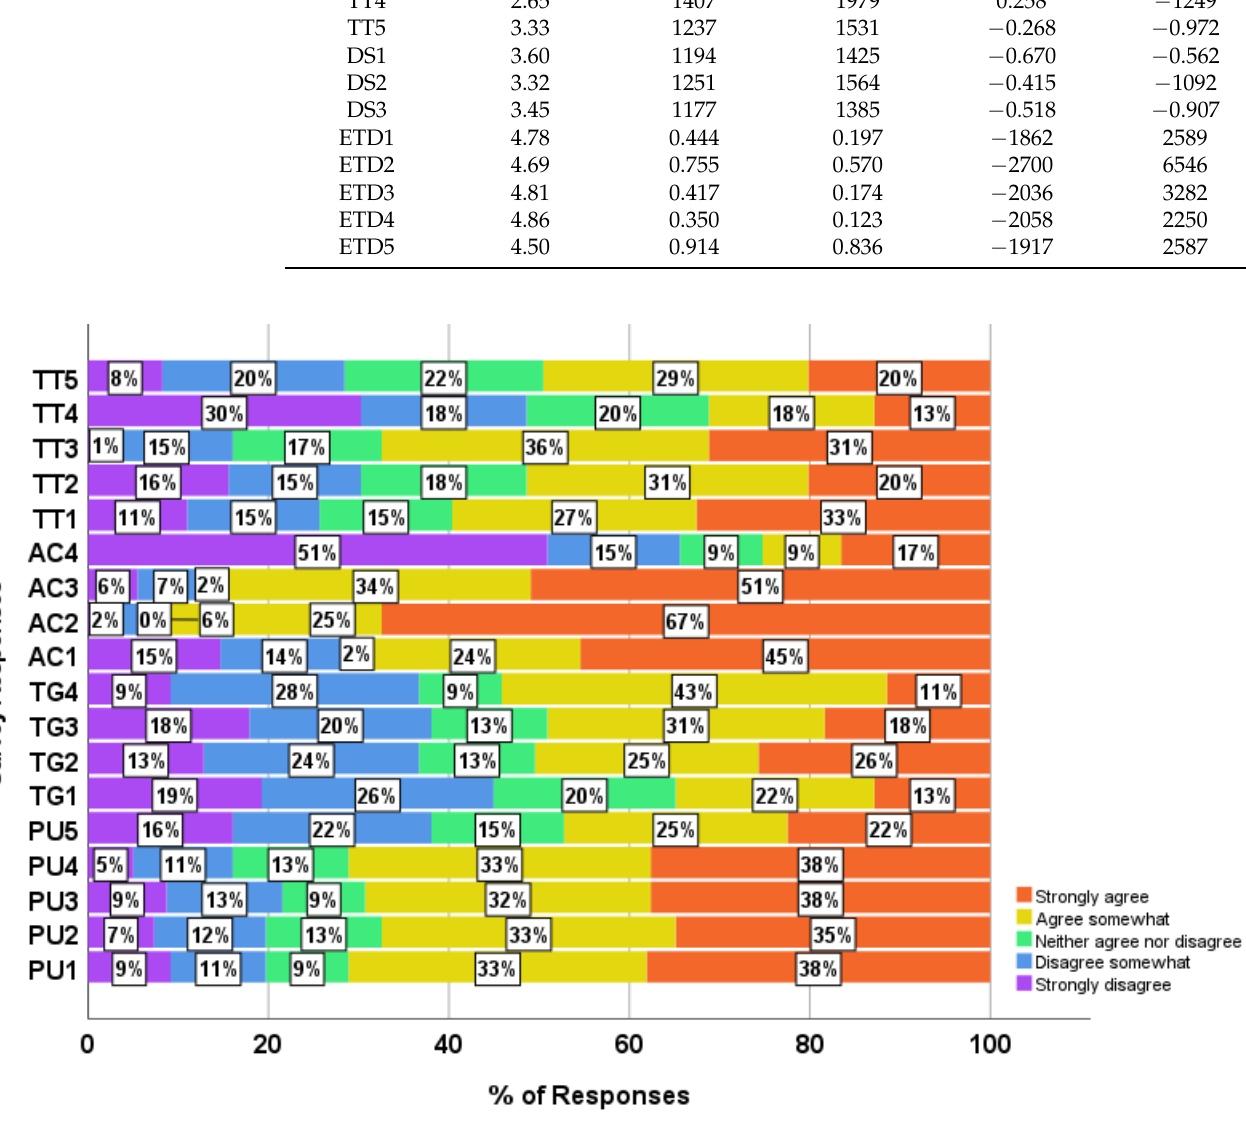
Figure 3. Distributions of the survey responses. ETD: Empathy toward the disabled, DS: Data secu- rity.